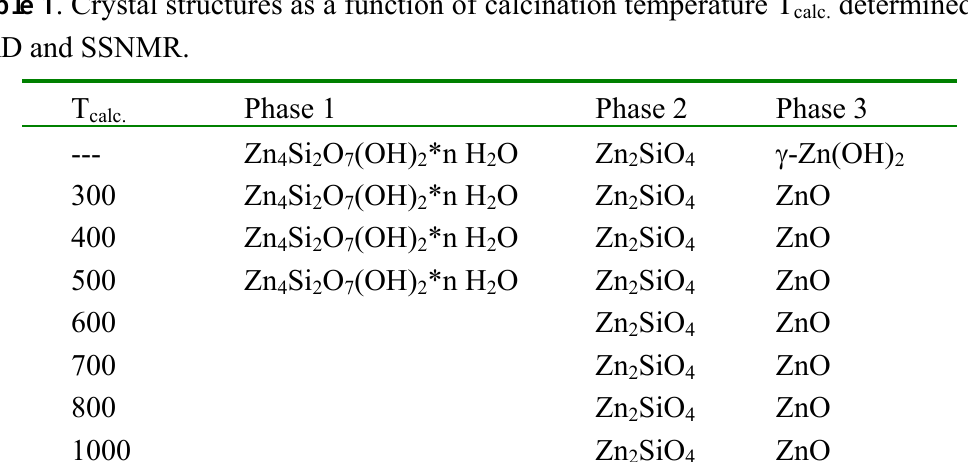
determined from calc.